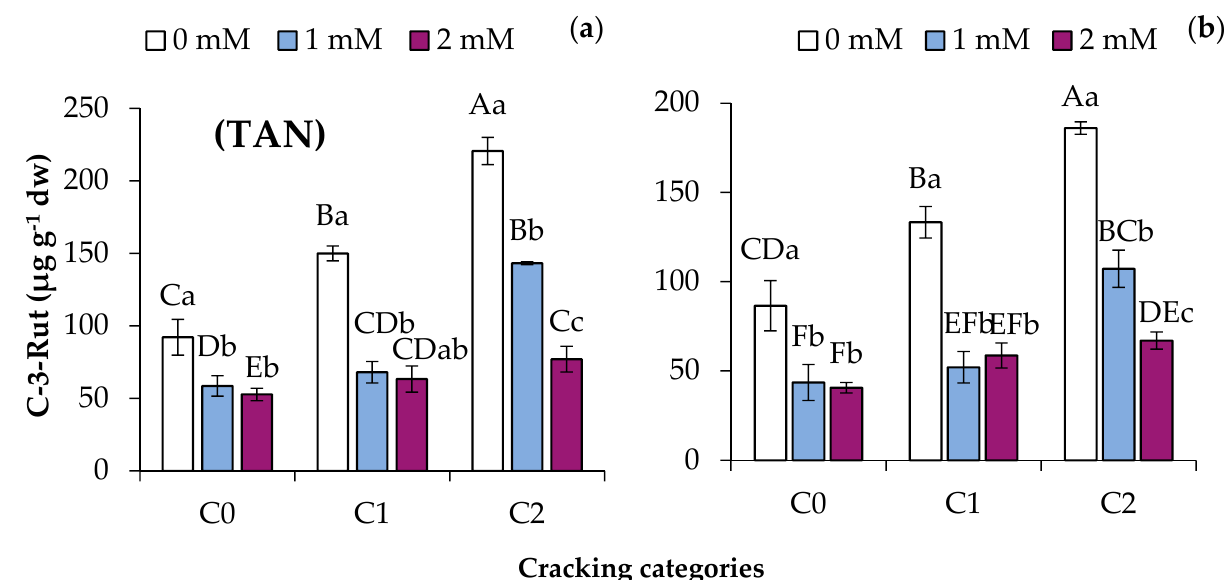
Figure 3. Changes in total anthocyanin content ( a ) and in cyanidin − 3 − rutinoside ( b ) in cracking categories of fig peel after preharvest treatment with different concentrations of salicylic acid (SA), in year 1. Categories: C0, sound fruit; C1, slightly cracked; C2, highly cracked. All data presented are means (n = 3); bars are standard deviations. Columns not sharing a common letter are significantly different by Tukey test ( α = 0.05). Lowercase letters correspond to one-way ANOVA in each cracking category; capital letters correspond to one-way ANOVA of all data.